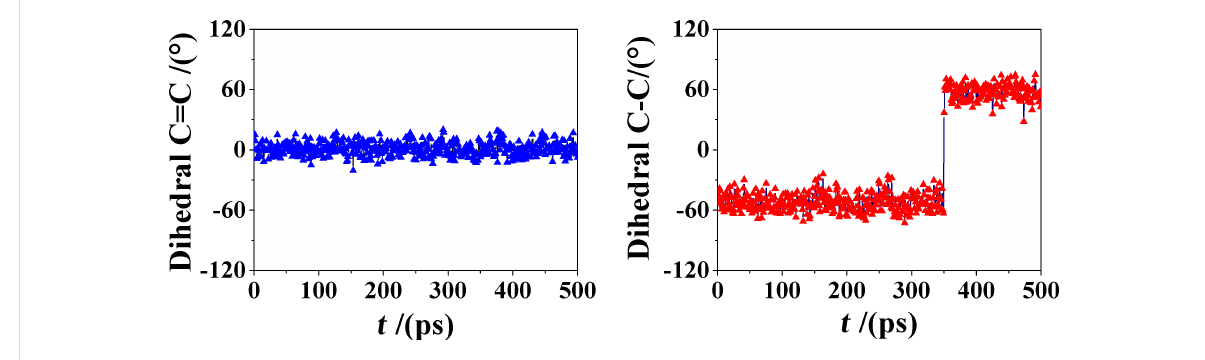
possibly related to the larger or smaller rigidity of the central ring in the tricyclic system: in fact, molecule 2 requires a smaller time interval before inclusion thanks to its larger fluctu- ations, related in turn to the flexibility of the central cycle, not constrained by the C9–C10 double bond present in molecule 1